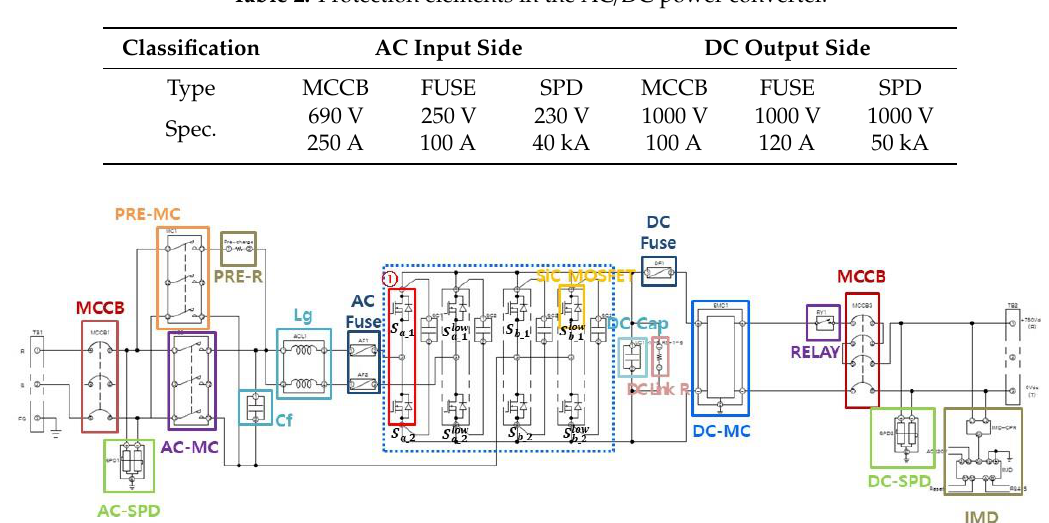
Figure 2. Circuit diagram of the AC/DC converter.